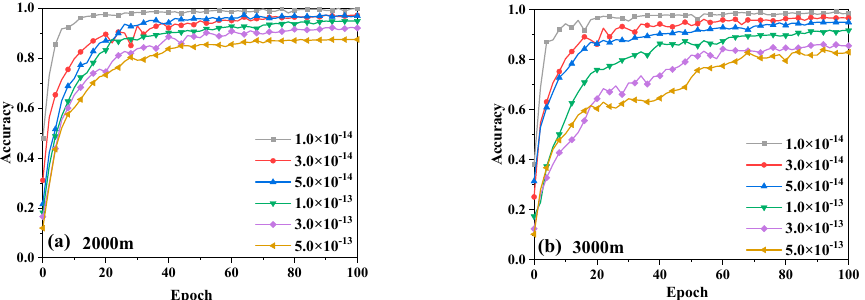
Figure 7. Accuracy of OAM mode recognition based on ResNet18 at different turbulence intensities ( a ) transmission distance: 2000 m ( b ) transmission distance: 3000 m.